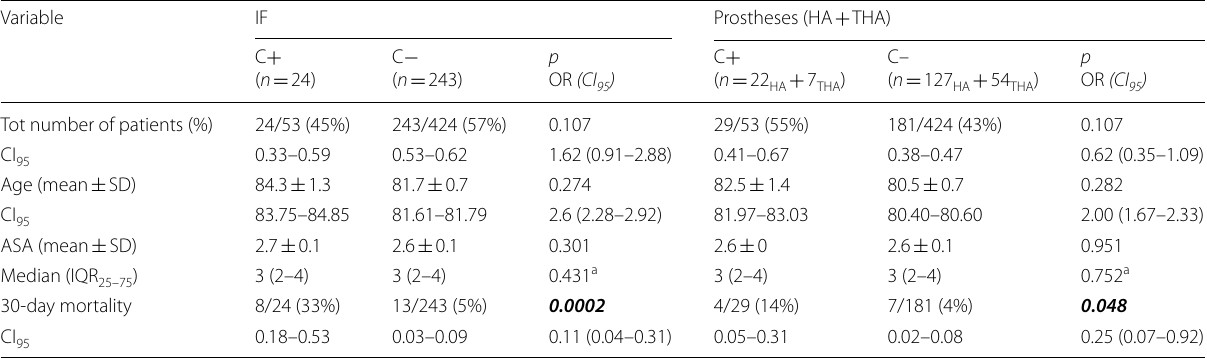
: patients with COVID-19; C : control group; see definitions in Materials and methods + − versus C + −